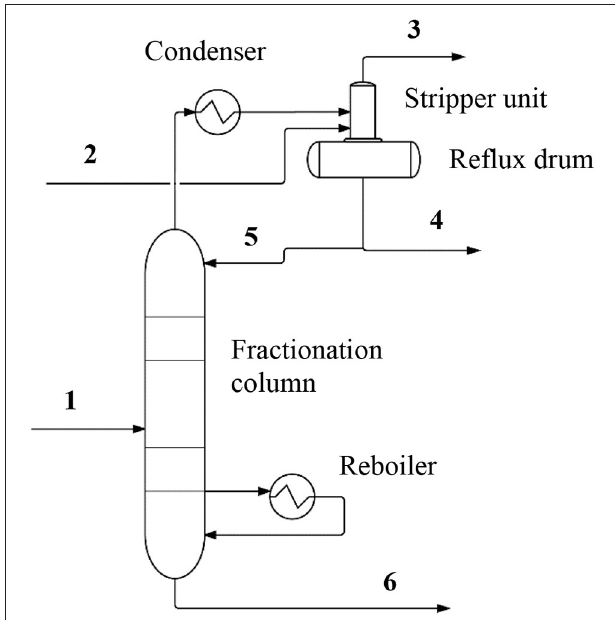
FIGURE 2 | A simplified diagram of a separations system showing the reactor and the gas sparger unit. Process and component labels are included, and the streams are identified by numbering as follows (select conditions are provided where appropriate): (1) Feed approximately 50% methanol (molar); (2) Carrier gas (composition described in text); (3) Waste gas (mainly CO 2 and carrier gas); (4) Methanol product; (5) Reflux stream; (6) Lean methanol